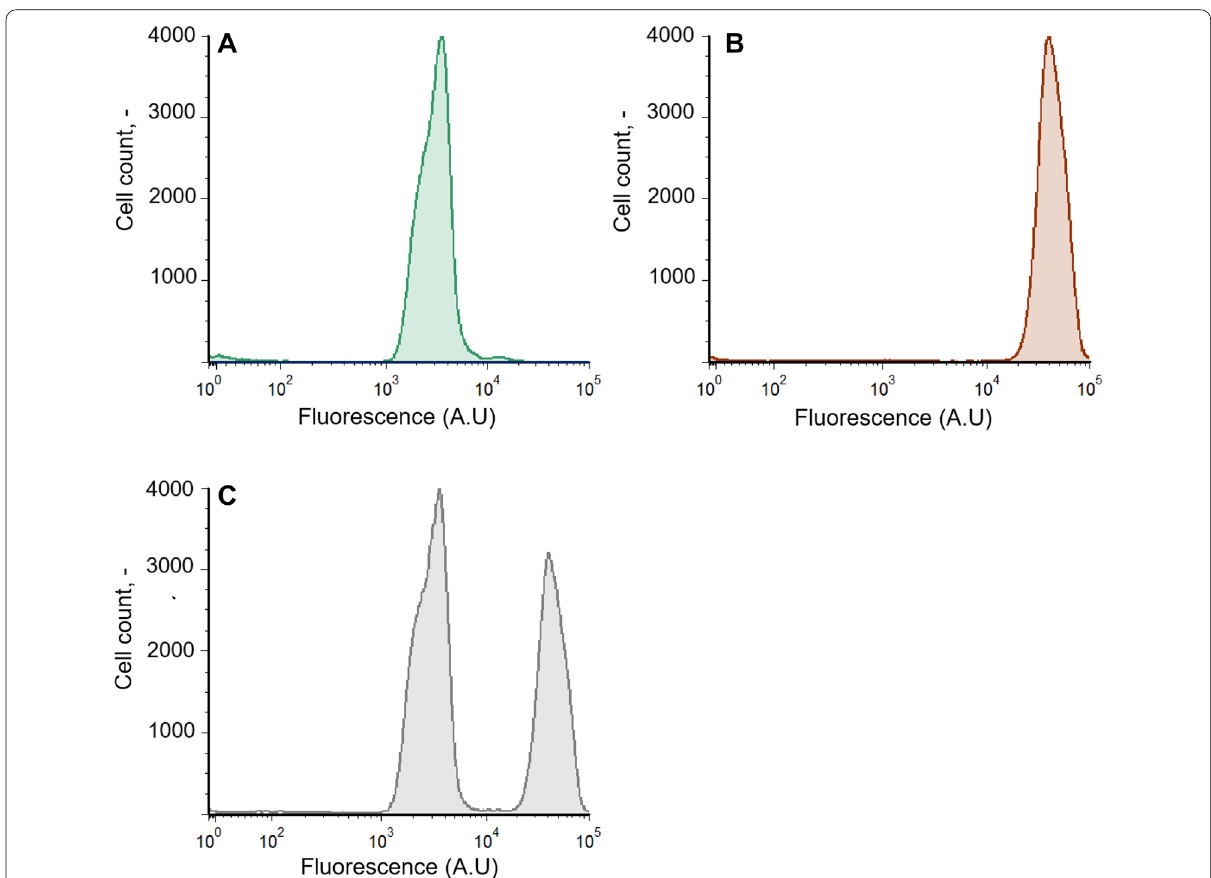
Fig. 2 Histograms of three samples with A 100% M. salina , B 100% T. lutea and C mixed sample containing both algal strains at an OD 750 of 0.2. X ‑axis shows the intensity of the fluorescence signal excited by a red laser at 640 nm and detected using the 660/10 nm bandpass filter. Y ‑axis shows the cell counts of the algae